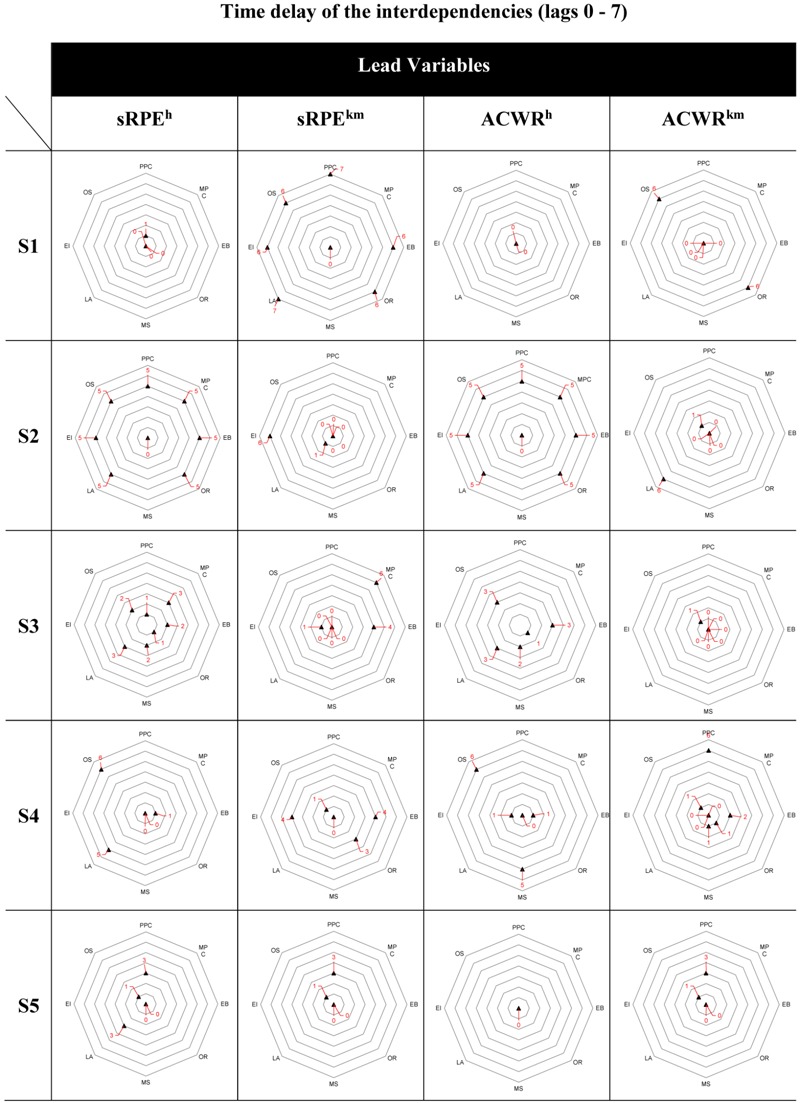
Individual profile display of the time delays (lag 0–7) for the examined athletes S1–S5 for the recovery and stress dimensions of the ARSS with sRPEh, sRPEkm, ACWRh, and ACWRkm as lead variables on the basis of net diagrams. PPC, Physical Performance Capability; MPC, Mental Performance Capability; EB, Emotional Balance; OR, Overall Recovery; MS, Muscular Stress; LA, Lack of Activation; NES, Negative Emotional State; OS, Overall Stress.